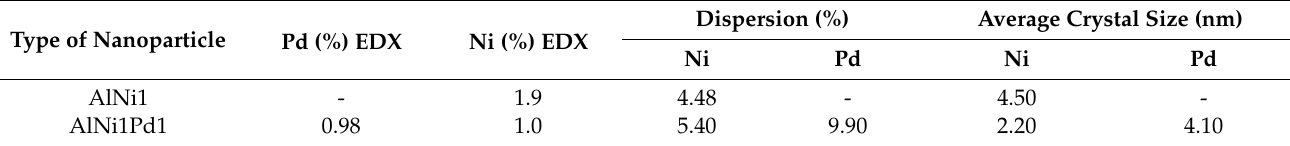
Table 2. Properties of nanoparticles AlNi1 and AlNi1Pd1 nanoparticles. Type of Nanoparticle Pd (%)